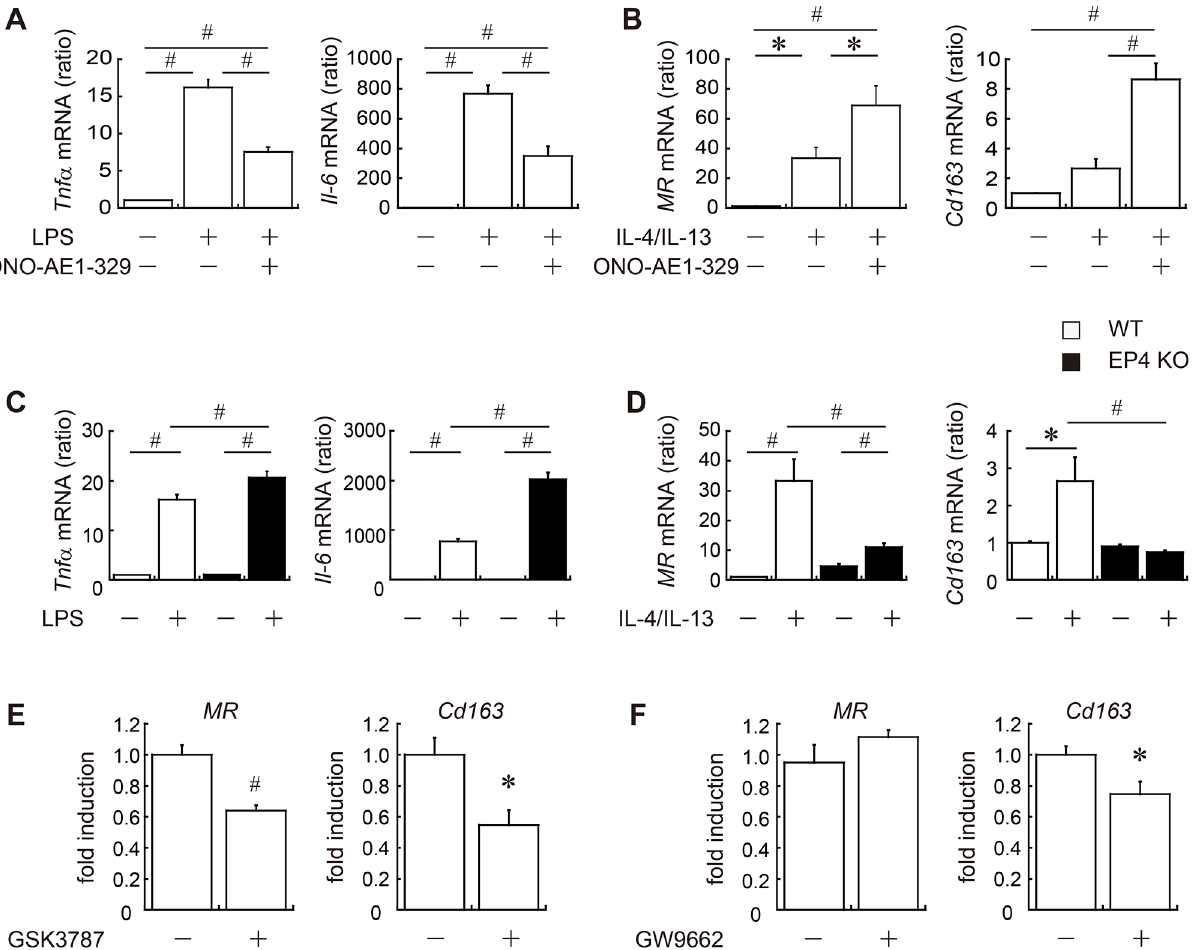
Fig 6. EP4 signaling is important in macrophage polarization. In vitro M1/M2 polarization assays were performed using peritoneal macrophages freshly isolated from 12 to 15-week-old male WT (white bar) or EP4-deficient mice (black bar). To determine M1 or M2 polarization, cells were incubated with 1 μ g/ml of LPS (A, C), or with 20 ng/ml of IL-4 and IL-13 (B, D), as well as with 1 μ M of EP4 agonist or vehicle. Eight hours later, marker gene expression for M1 ( Tnf α and Il-6 ) (A, C) or M2 ( MR and Cd163 ) (B, D) polarity was measured. To clarify the role of PPARs in EP4-dependent M2 polarization, peritoneal macrophages were pretreated with GSK3787 (PPAR δ antagonist) (E), GW9662 (PPAR γ antagonist) (F) or vehicle prior to the administration of IL-4/IL-13 and the EP4 agonist. Results are expressed as the fold induction of M2 genes compared with unantagonized, vehicle-treated cells. All values are mean ± SEM (n = 6 each). * p < 0.05; ] p < 0.01. LPS,